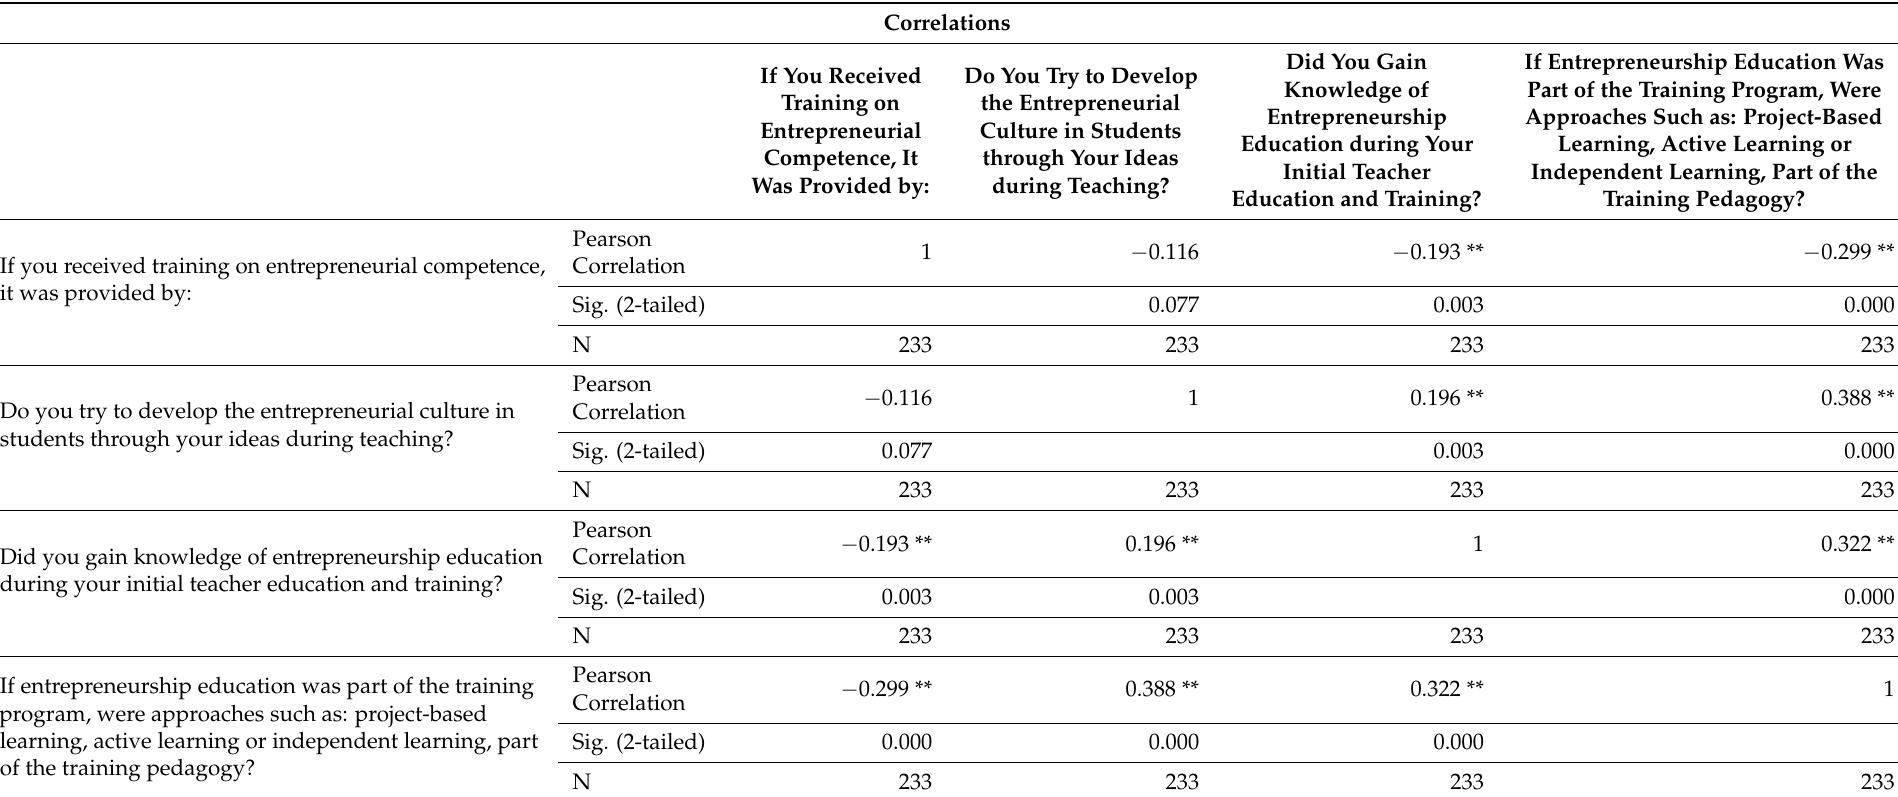
Table 7. Correlation matrix of variables Q8, Q10, Q11,